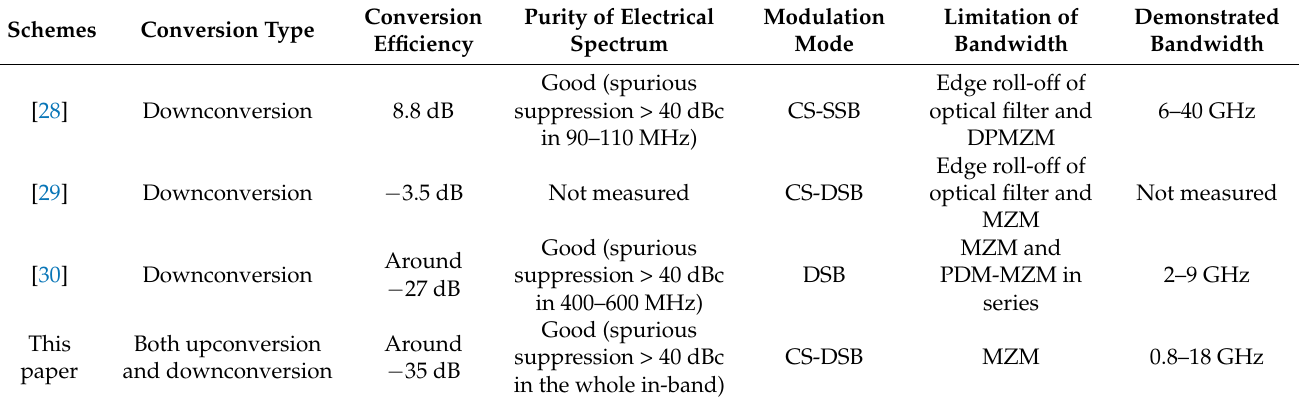
Table 2. Comparison of the conversion ability of several microwave photonic